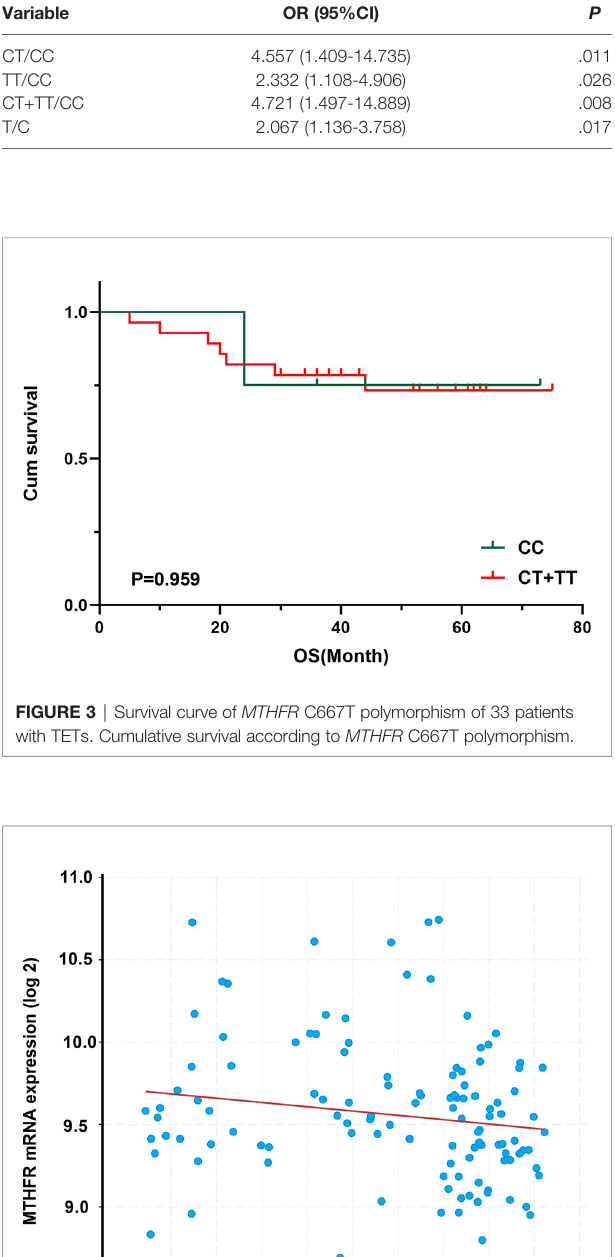
TABLE 6 | Correlation analysis between MTHFR C667T genotypes and TET susceptibility. Variable